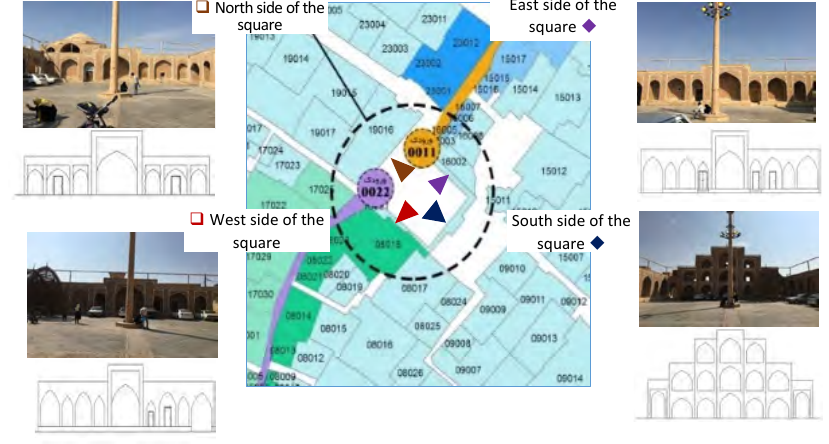
Fig. 4: exterior skin of Shah Abolghasem Square in Yazd Fig . 4: exterior skin of Shah Abolghasem Square in Yazd